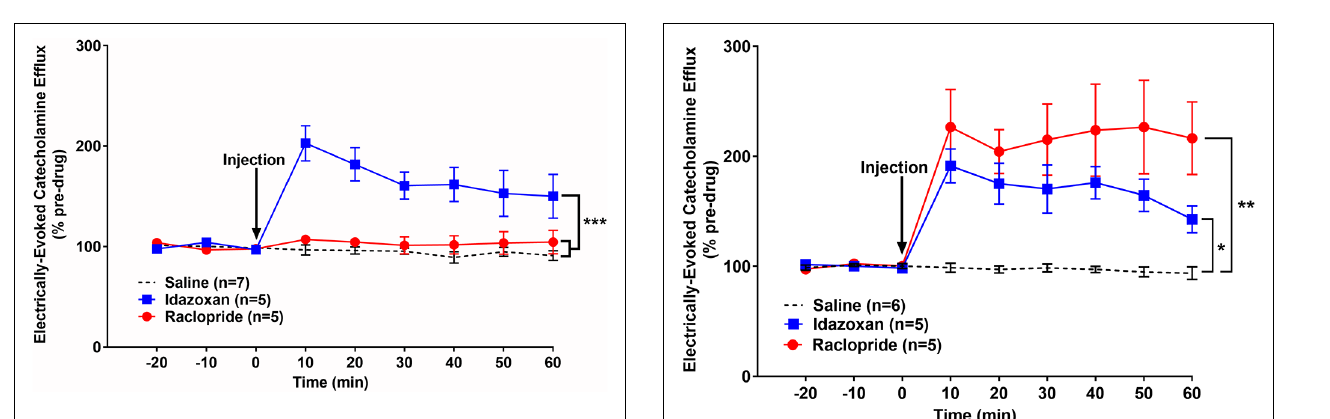
FIGURE 4 | Idazoxan significantly increased norepinephrine (NE) in the basolateral amygdala (BLA) following locus coeruleus (LC) electrical stimulation in non-stressed rats. Anesthetized rats were used to quantify LC-evoked CA release in the BLA, as measured by fast-scan cyclic voltammetry. After a stable baseline was established, saline, idazoxan, or raclopride was administered (black arrow). Idazoxan resulted in a significant increase in the measured signal compared to the saline control. There was no change in the CA signal following injection of raclopride compared to the saline control. Efflux values are presented as mean ( ± SEM) percent of a pre-injection baseline average. Saline: n = 7; Idazoxan: n = 5; Raclopride: n = 5. *** p < 0.001.